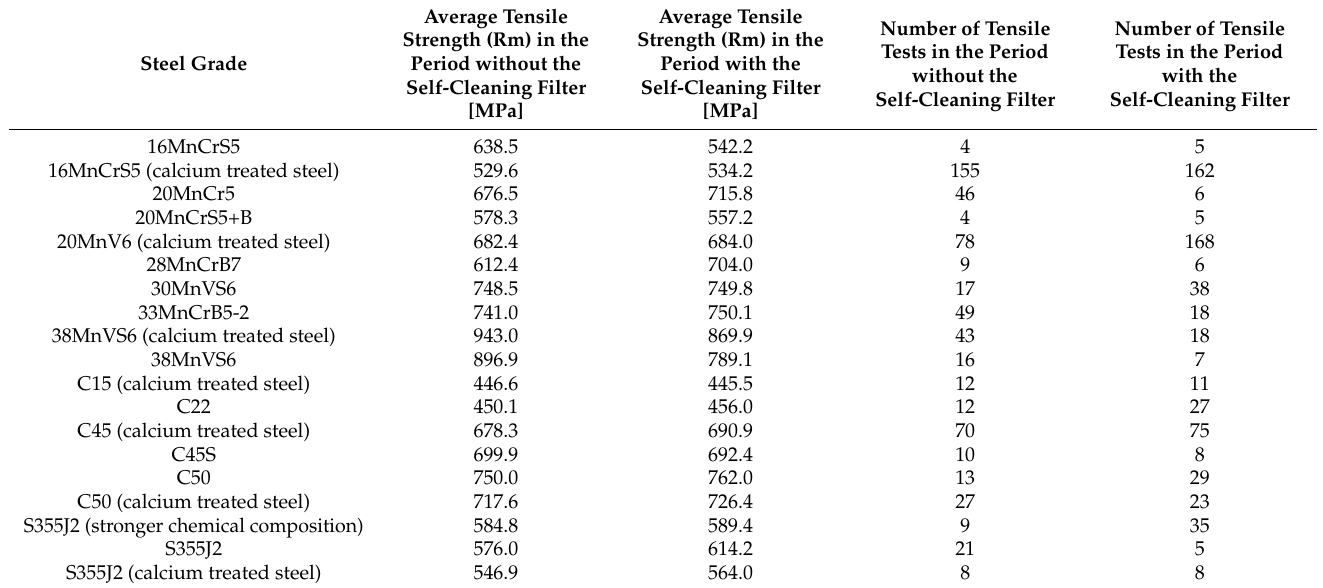
Table 3. Tensile test results for 19 steel grades for each period—without the installed self-cleaning filter or with the installed self-cleaning filter.